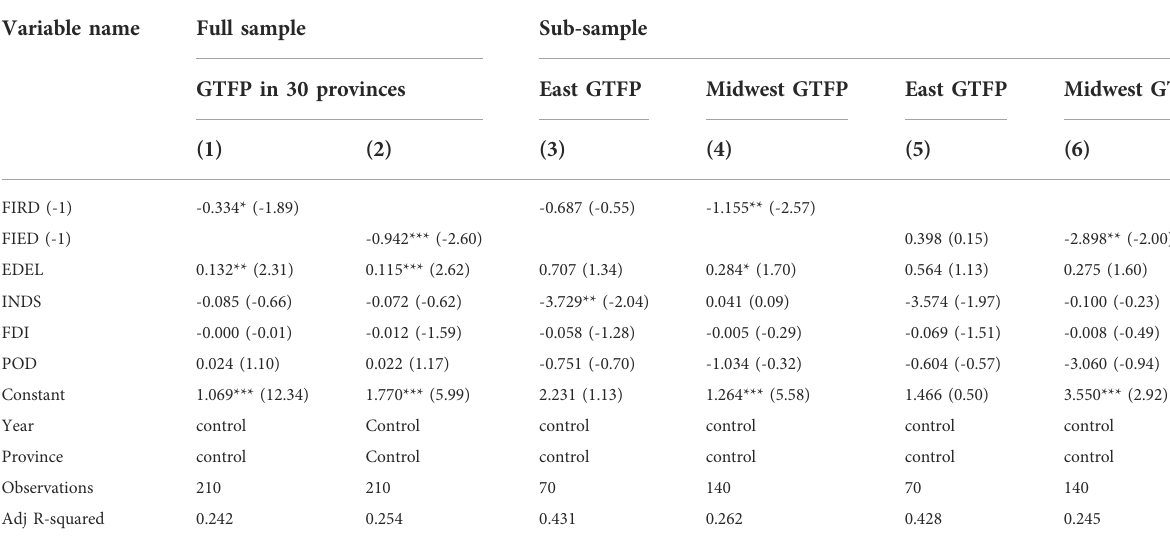
TABLE 6 Results of benchmark regression and heterogeneity regression.